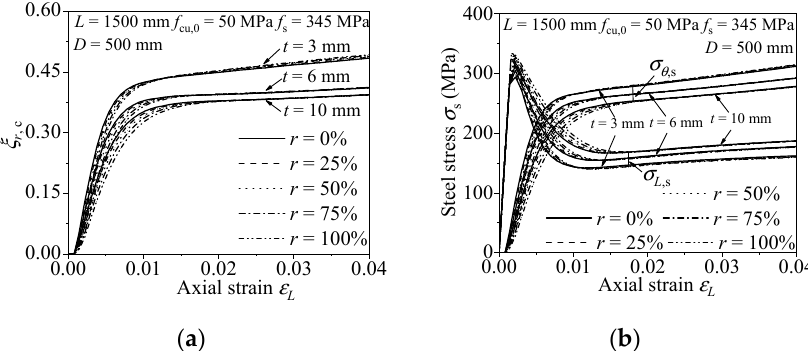
Figure 9. Effect of steel ratio on the confinement effect of RACFCST stub columns: ( a ) radial stress–axial strain curves; ( b ) ξ r,c –axial strain curves.